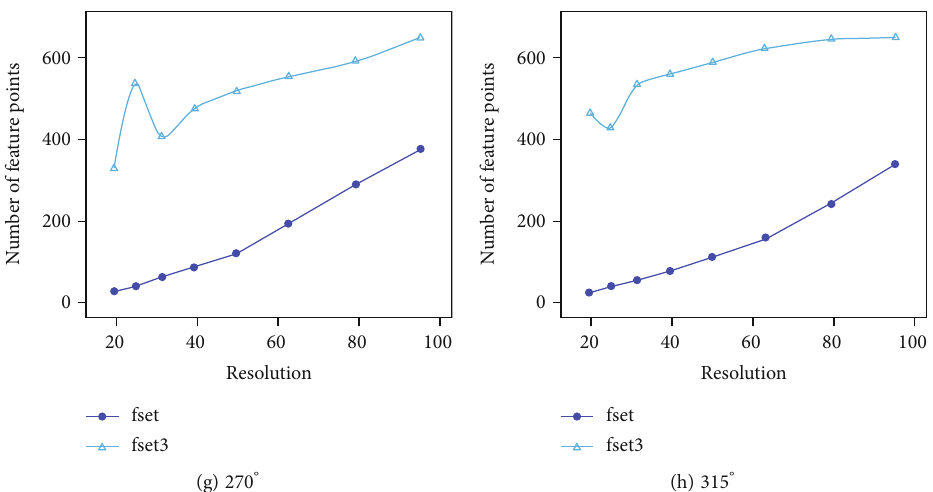
Figure 5: Trend graph of the number of feature points (fset: the number of feature points used for continuous tracking; fset3: the number of feature points used for initializing tracking and recognizing